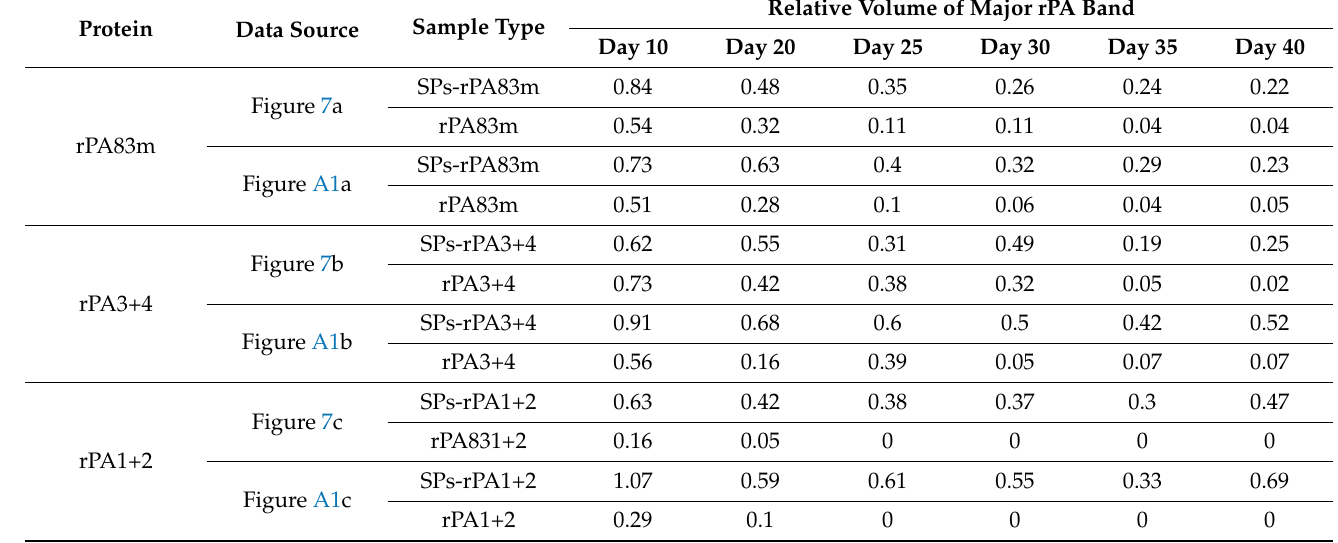
Table A1. Dynamics of rPA83m, rPA3+4 and rPA1+2 degradation in individual form and within compositions with SPs.